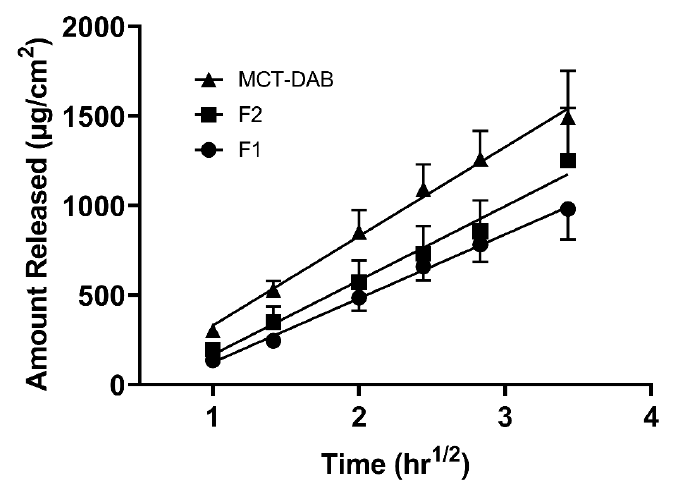
Figure 2. In vitro release of DAB microemulsion formulations across a dialysis membrane. All data are expressed as mean ± standard error, n = 3.